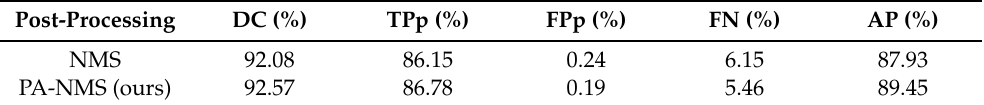
Table 3. The influence of PA-NMS algorithm on model performance.